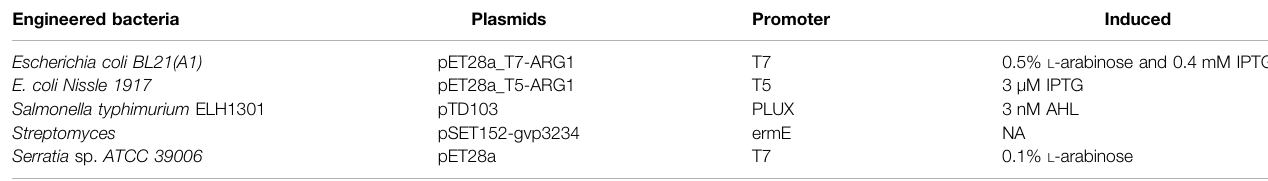
TABLE 1 | The production of gas vesicles (GVs) from engineered bacteria in ultrasound imaging (Bourdeau et al., 2018; Huang et al., 2019). Engineered bacteria